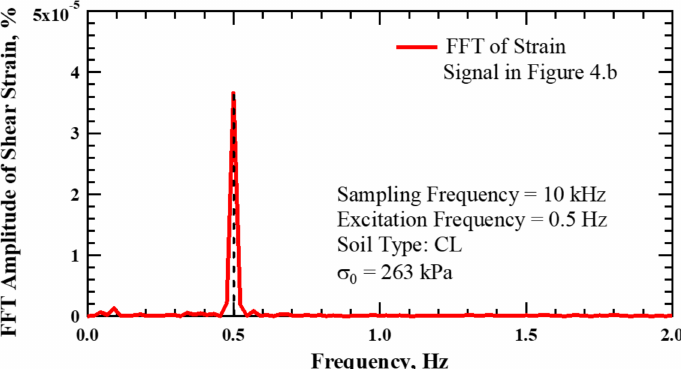
Figure 8. The transformed strain signal in the frequency domain.